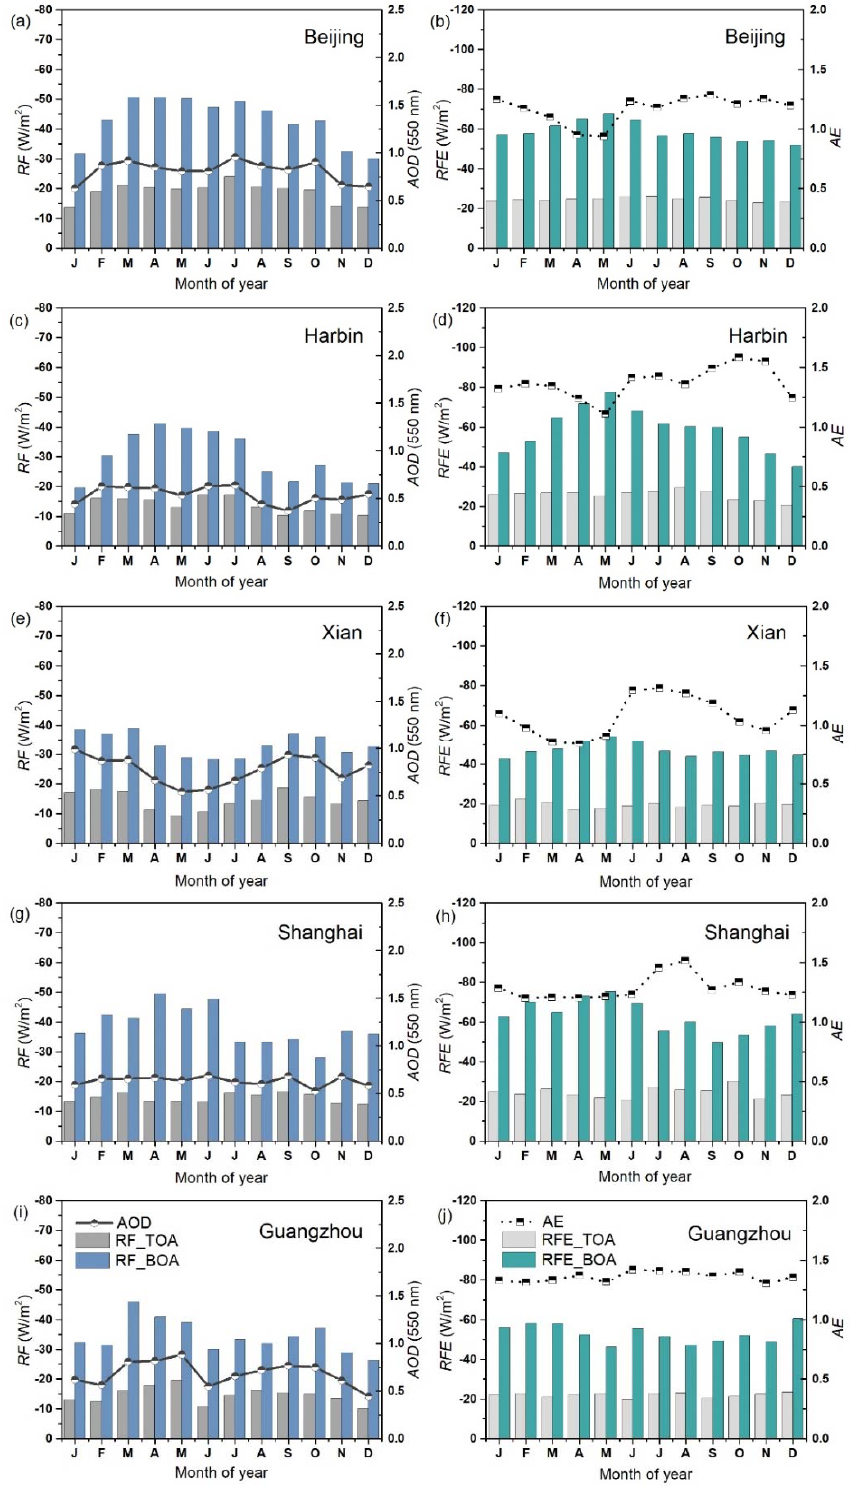
Figure 4. As Figure 2, but for the SONET urban and suburban sites. ( a , b ) Beijing; ( c , d ) Harbin; ( e , f ) Xian; ( g , h ) Shanghai; ( i , j ) Guangzhou.